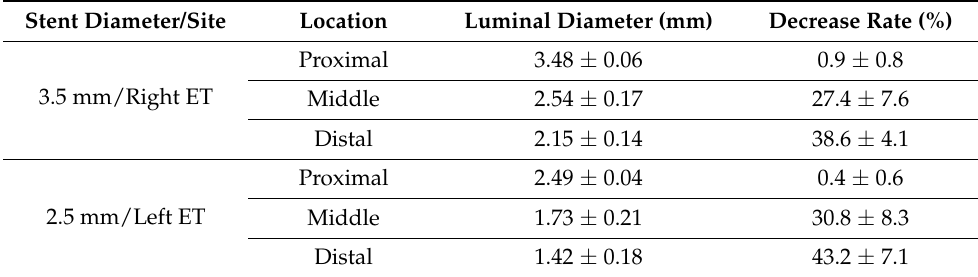
Table 1. Mean luminal diameters and decrease rates at the proximal, middle, and distal portions of the placed stents in a porcine Eustachian tube (ET)